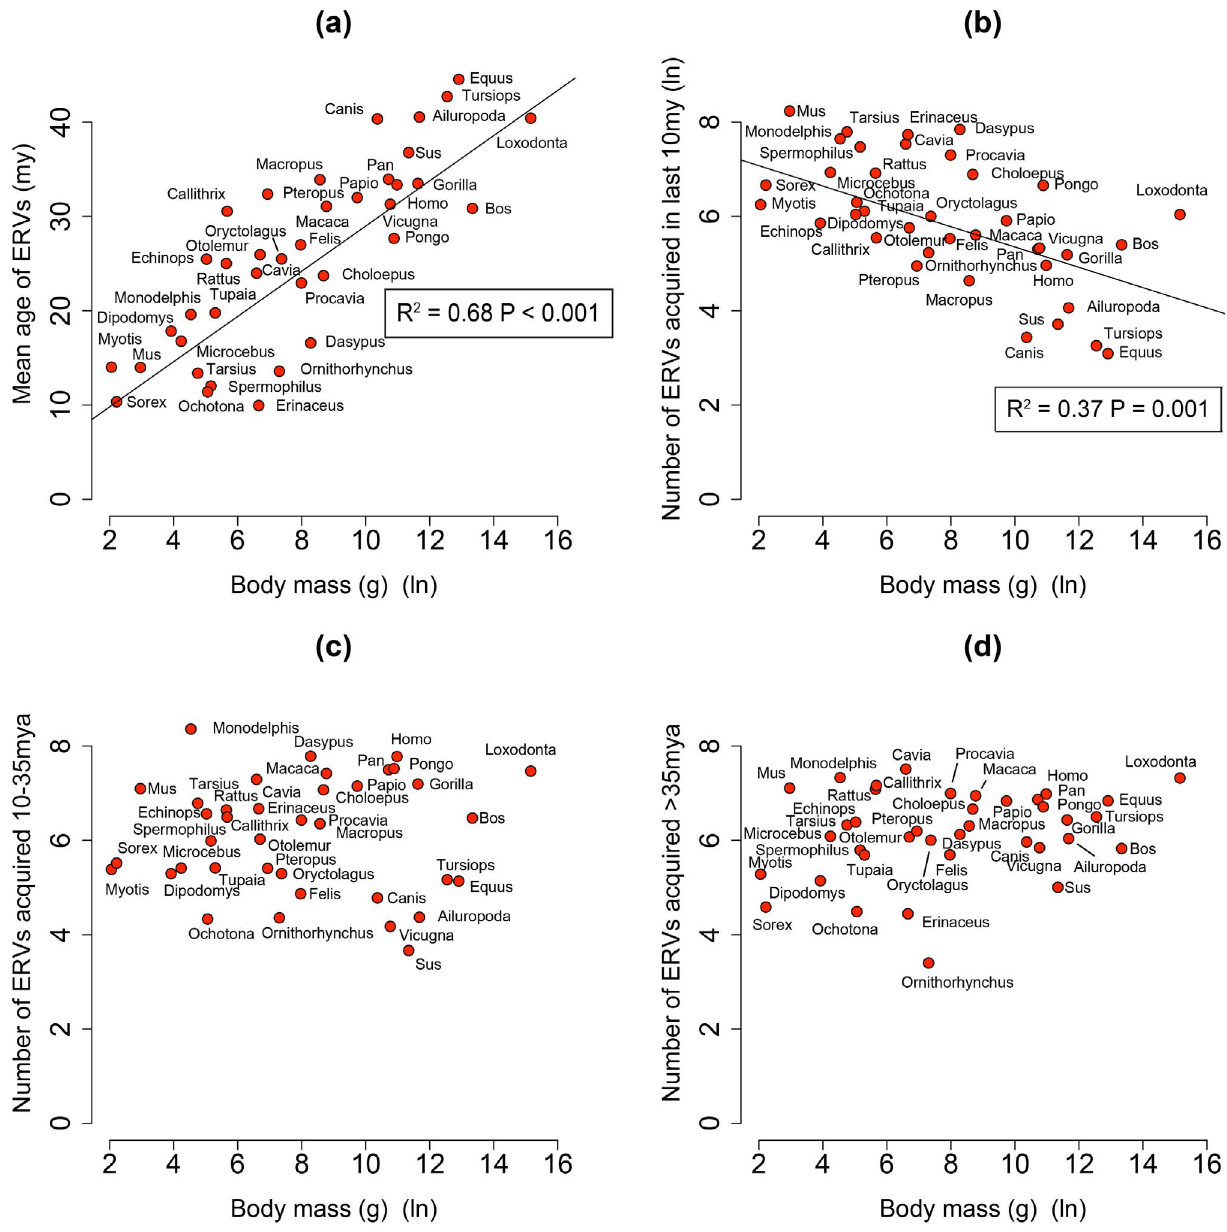
Figure 1. (a) Correlation between mean age of all ERV integrations and body mass from the genomes of 38 mammals. Body mass is log-transformed, and the mean ages are calculated correcting for the substitution rate (R 2 =0.68, P , 0.001). (b, c, d) The relationship between ERV count and body mass for the number of ERV integrations acquired over the last 10 my, between 10–35 mya and . 35 mya in the genomes of 38 mammals (both values log-transformed). The trend lines representing the slope for the regression, corrected for phylogenetic non-independence, and accompanying P-values are plotted. We have taken into account the effect of body size on substitution rate in calculating the ages.